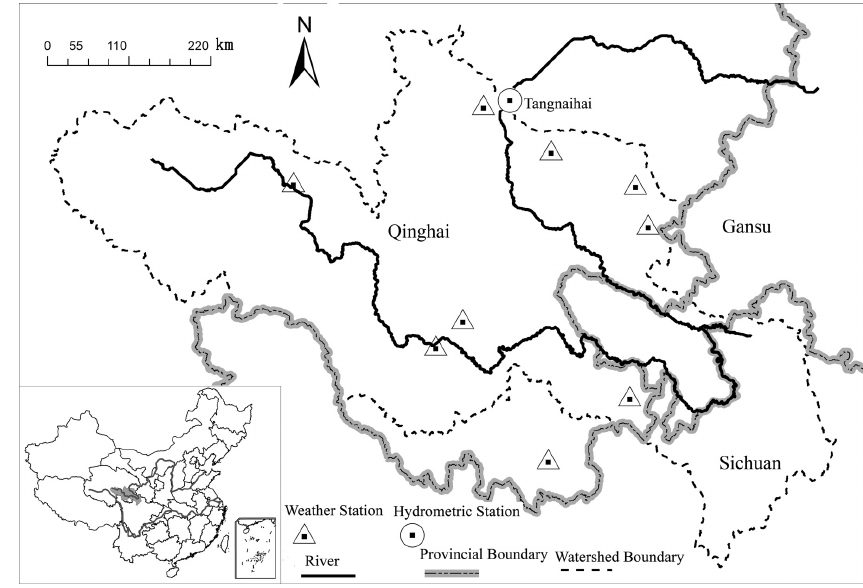
Fig. 1. The geographic location of Headwaters region of Yellow River and the location of hydrometric station used in this